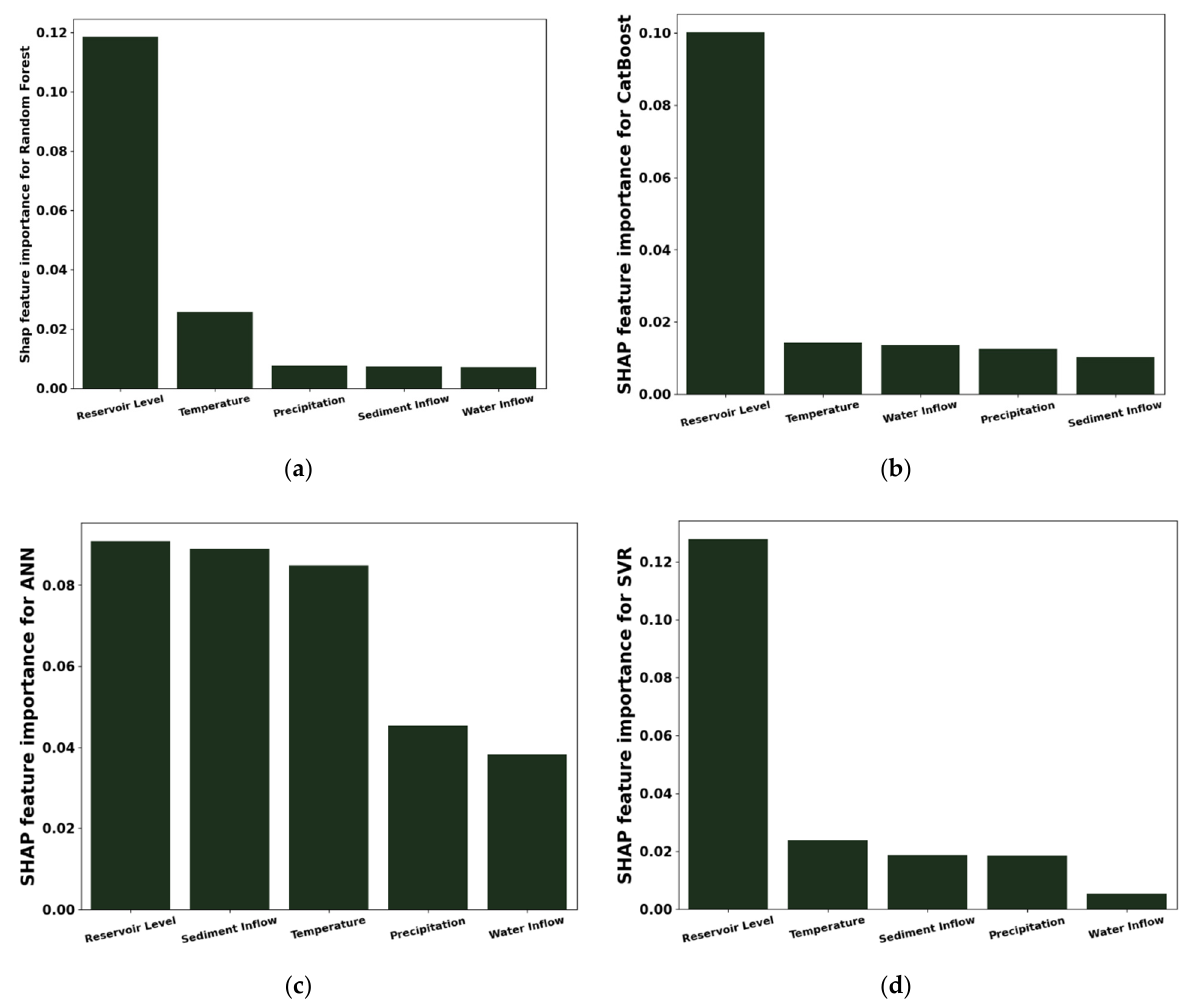
Figure 12. SHAP feature importance plots ( a ). Random forest ( b ). CatBoost ( c ). ANN ( d ). SVR.